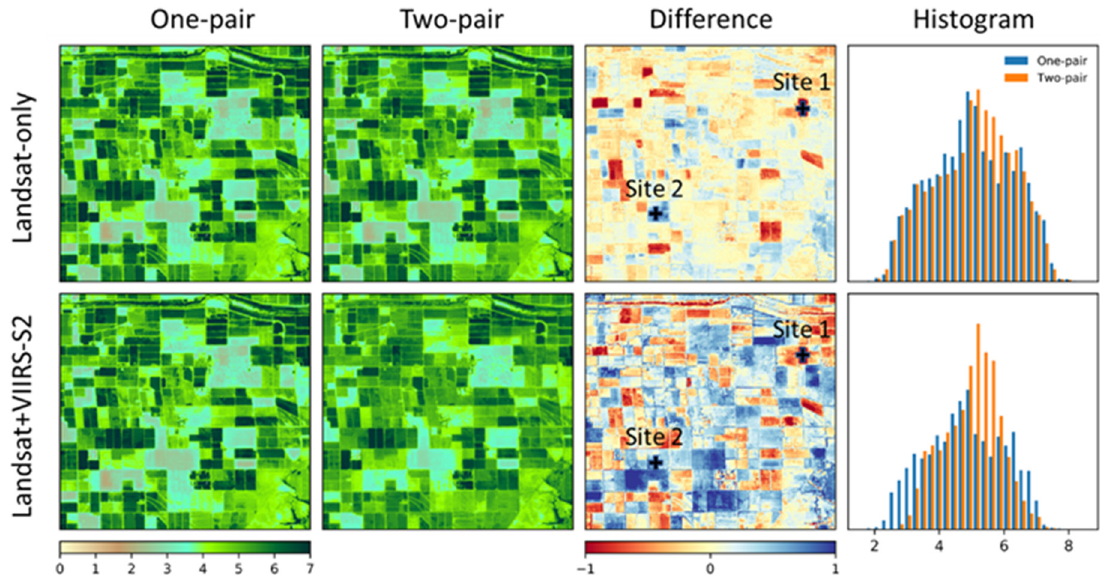
Figure A2. The comparison between one-pair ( first column ) and two-pair ( second column ) fused ET on DOY 218 for both Landsat-only ( upper row ) and Landsat + VIIRS-S2 fusion ( bottom row ). The difference maps ( third column ) show two-pair minus one-pair ET. The histograms ( fourth column ) show the frequency distribution of ET values.